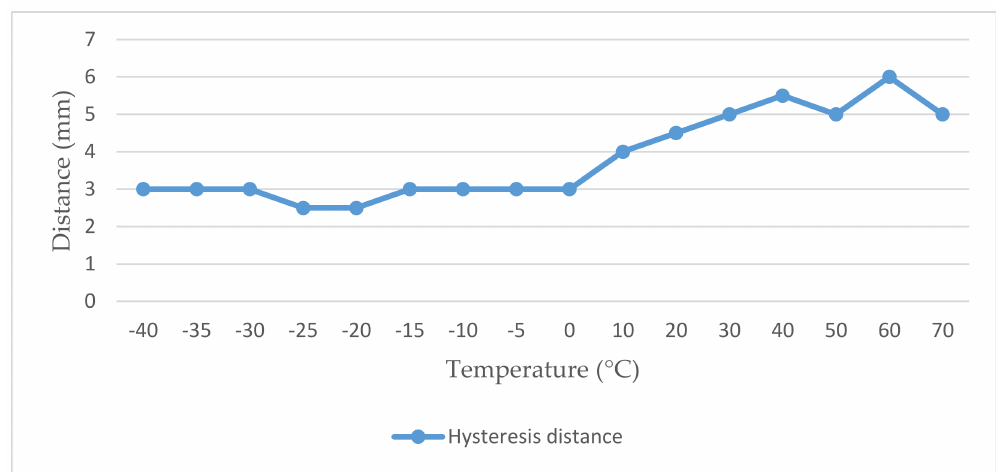
Figure 7. Graphical representation of the values of the hysteresis phenomenon of the magnetic contact SA 220.